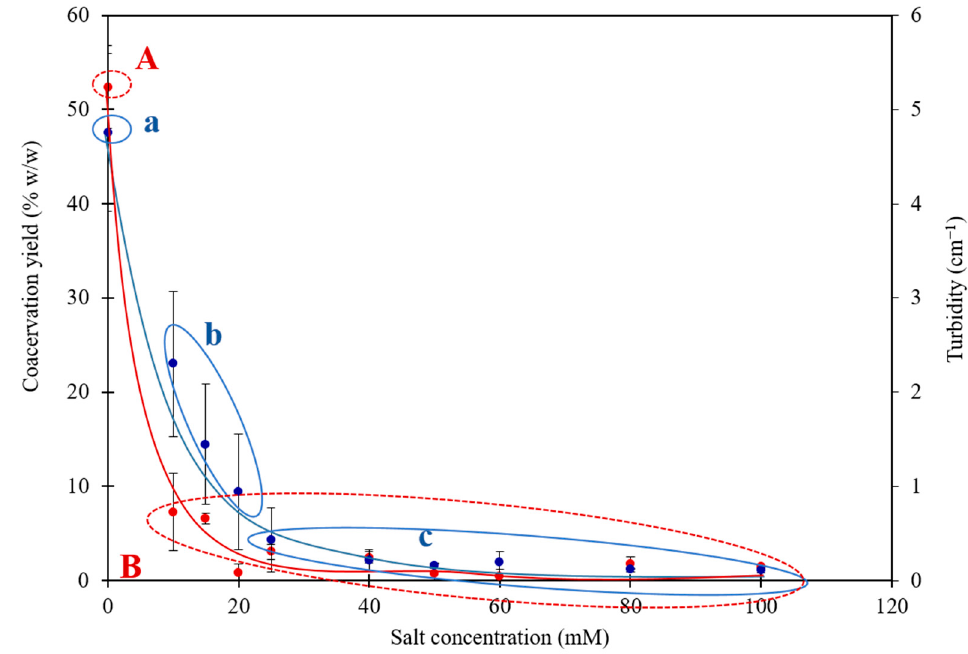
Figure 1. Evolution of lactoferrin– β -lactoglobulin coacervate yield ( red ) and turbidity ( blue ) as a function of salt concentration after direct mixing in 10 mM MES buffer, pH 5.5. Total protein con- centration of 0.55 mM. The ANOVA on NaCl concentration was significant ( p < 4 × 10 − 9 and p < 3 × 10 − 5 for the coacervates yield and turbidity, respectively). [a,b,c] and [A, B]: values not sharing the same letter are significantly different according to the Tukey’s multiple comparison test ( p < 0.05).